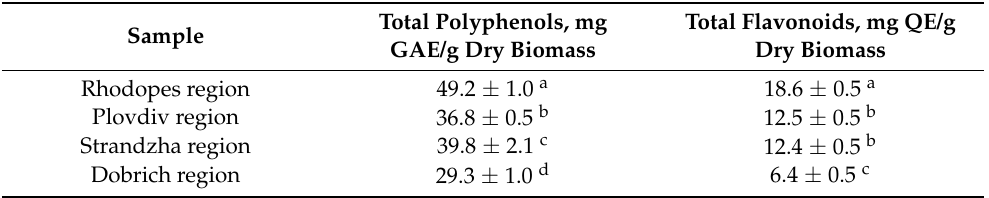
Total Flavonoids, mg QE/g Dry Biomass